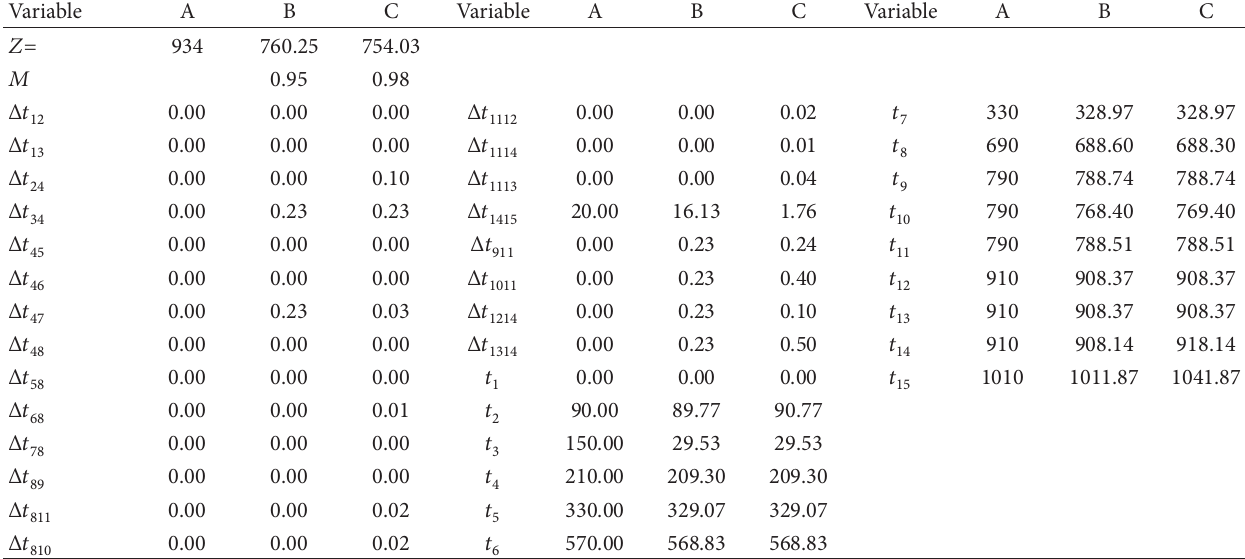
Table 3: Solutions of the Zimmermann’s approach and flexible fuzzification model for threshold 𝛼 = 0.98 .